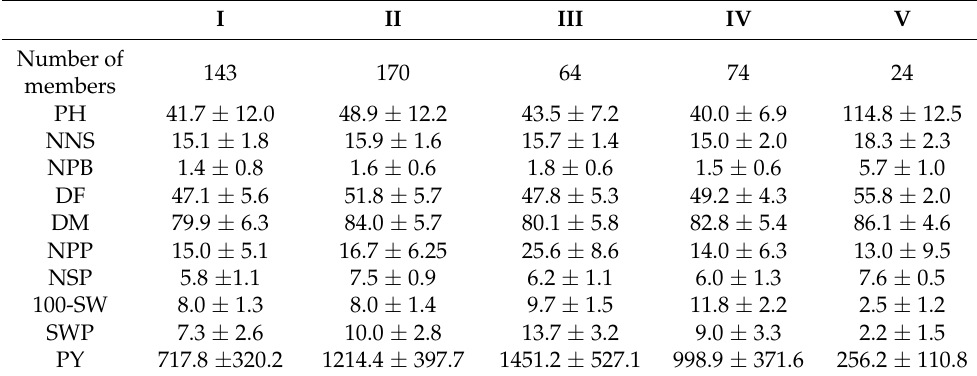
Figure 5. Hierarchical clustering dendrogram analysis. The 475 adzuki bean accessions were grouped into 5 groups (I–V). The clusters I, II, III, IV, and V had 143, 170, 64, 74, and 24 accessions, respectively. Dots with different color represents landraces (red), cultivated varieties (blue) and wild (green). Table 5. The phenotype of traits of five groups by cluster